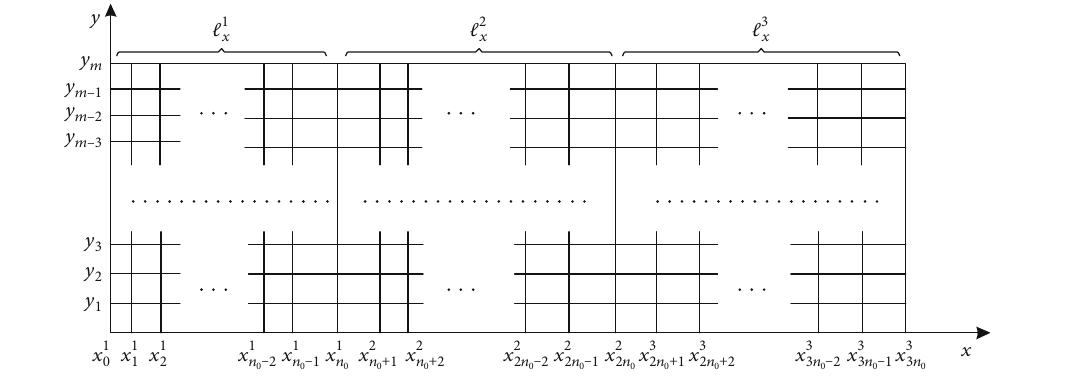
Figure 2: Mesh for the system consisting of 3 plates. Table 1: The mechanical properties of the plate-forming